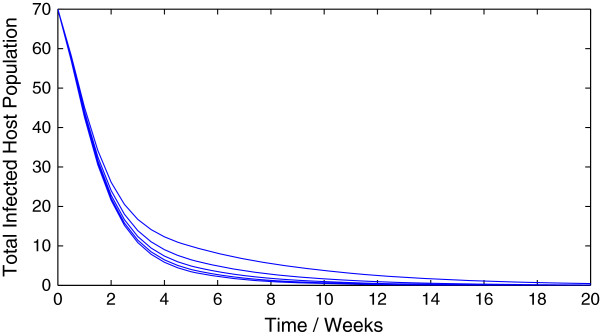
Sample trajectories of model (1.1) with R0 < 1.